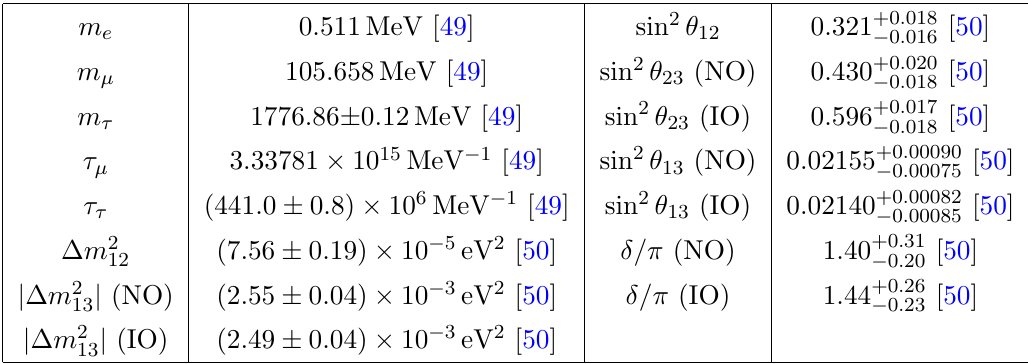
Table 2 . The input parameters for leptons in our analysis. The notation for the lepton mixing is following ref. [49]. NO (IO) is short for the normal (inverted) ordering neutrino mass hierarchy. The central values are used in our